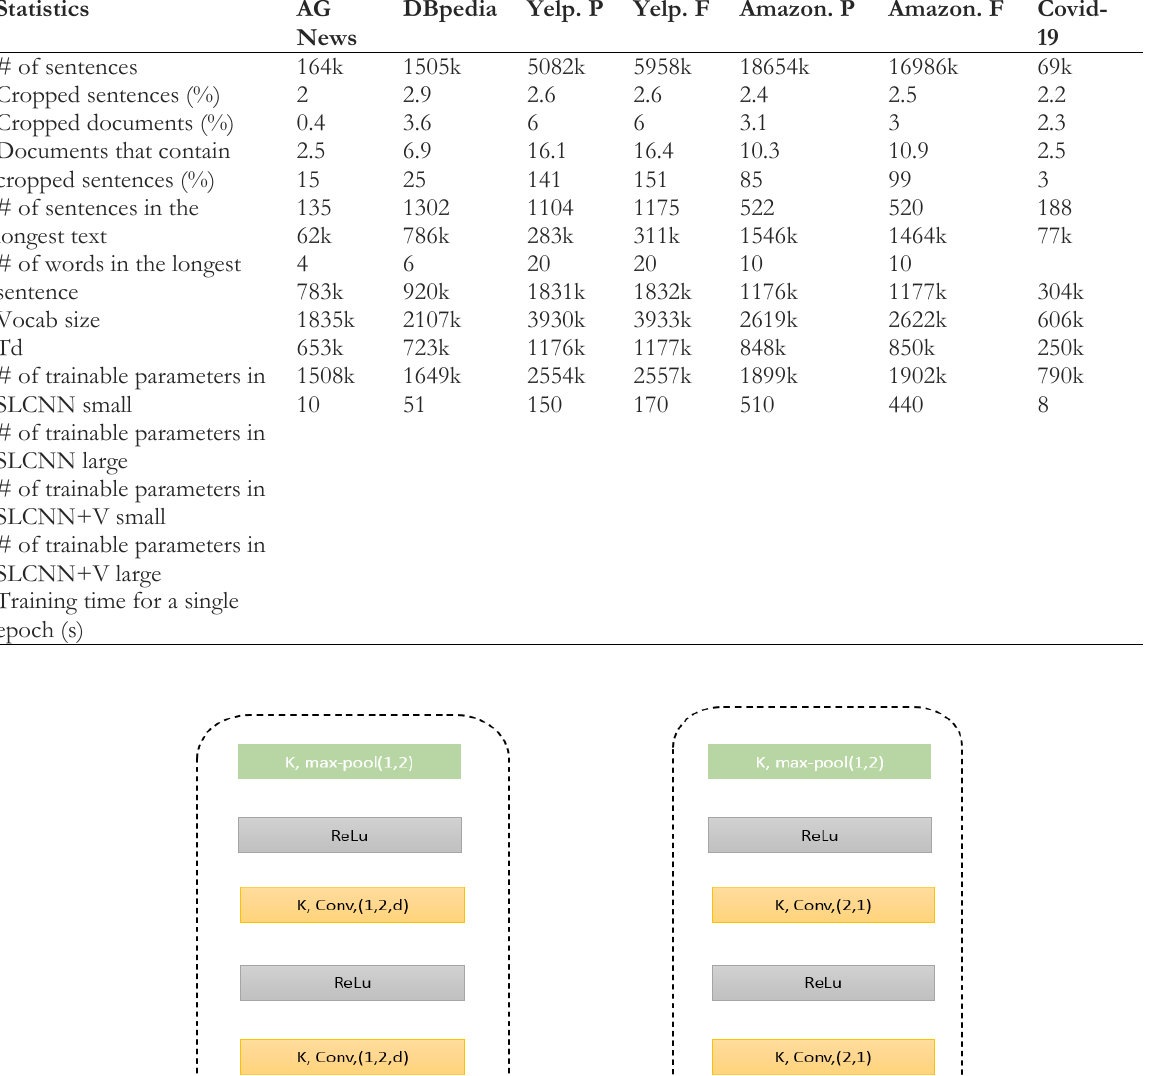
Table 3. The statistical information of the datasets.